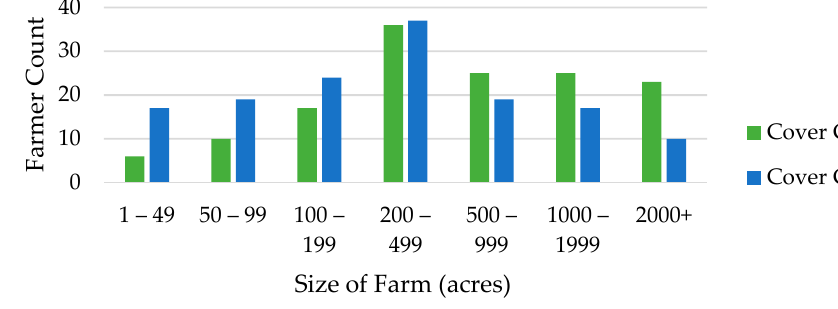
Figure 3. Distribution of responses by farm size.